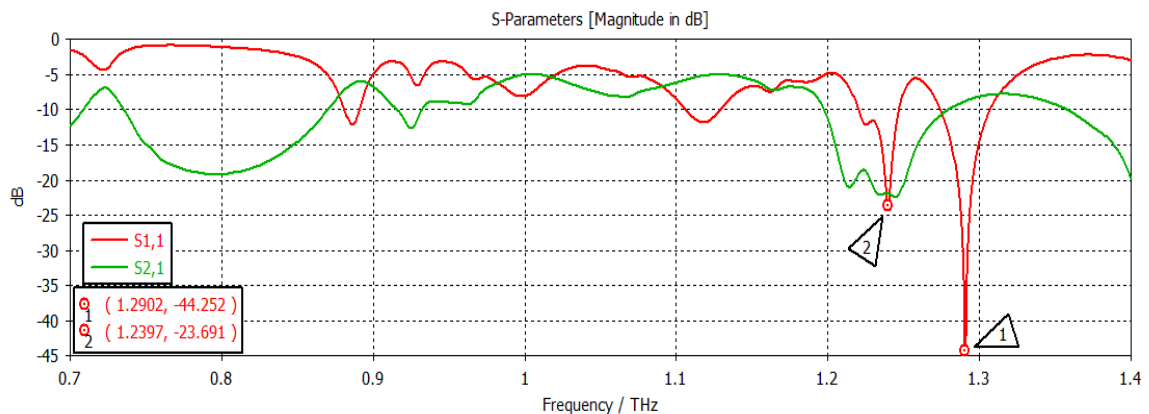
Figure 2. S-parameter results. Table 1. SIW filter